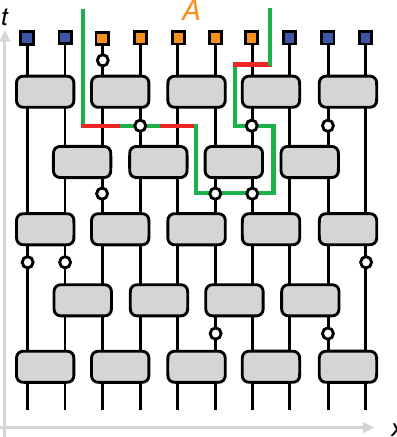
FIG. 1. The hybrid circuit model and minimal cut. In most of this paper we consider hybrid circuits as shown in the figure. The unitary gates (gray blocks) are arranged in a brickwork, and are sampled randomly and independently from either the Haar unitaries or the Clifford unitaries. The measurements (white circles) are projective, performed independently at each loca- tion with probability p . Superimposed is a “minimal cut” of the circuit geometry, that serves as a domain wall separating the subregion A (orange) from A (blue) with minimum energy [given by the number of unmeasured links (red) that it crosses]. Although the minimal cut provides a heuristic picture of the “entanglement domain wall” for the vN entropy, the two should be distinguished—see the main text for more